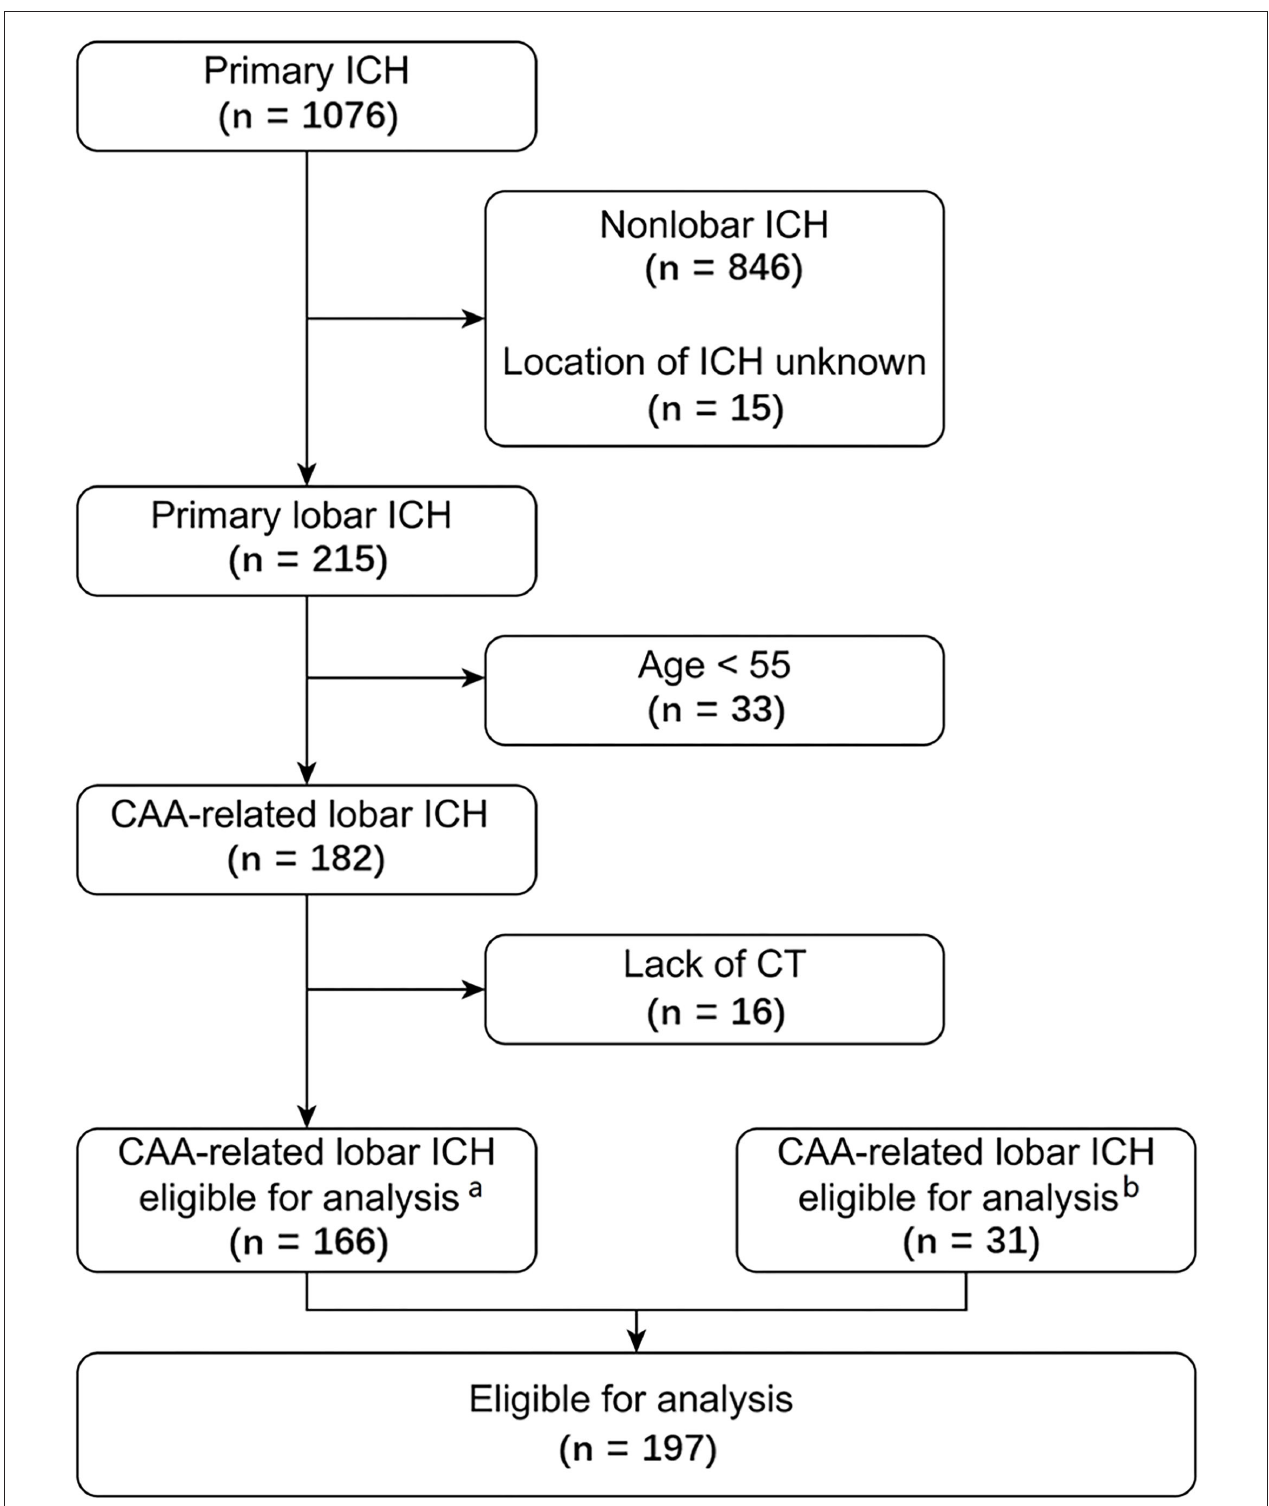
FIGURE 2 | Flow chart of the patient selection process. a Patients included in the multicenter cohort. b Patients admitted to our center during the same period who were not included in the multicenter cohort. CAA, cerebral amyloid angiopathy; ICH, intracerebral hemorrhage.